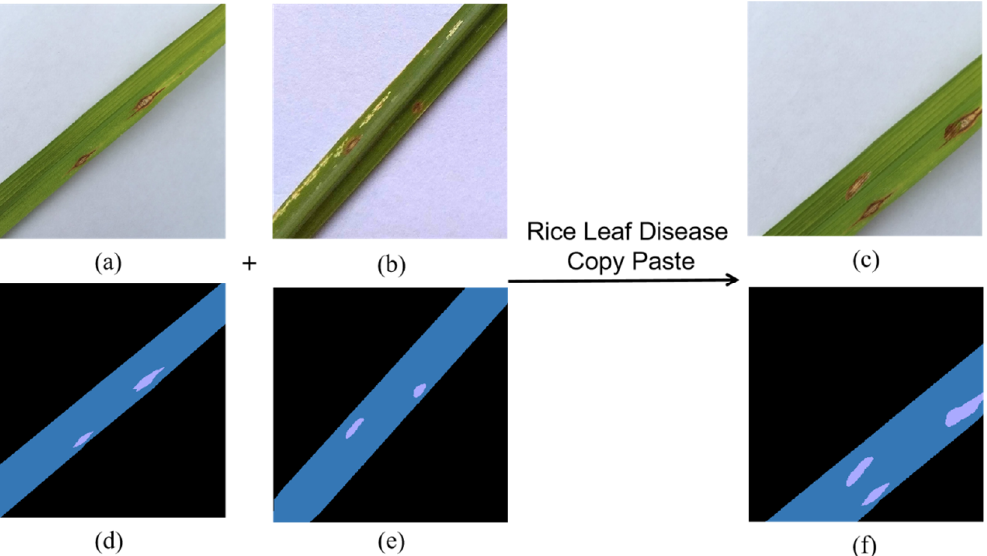
Figure 3. RLDCP data enhancement example: ( a ) RGB image of the pasted object, ( b ) RGB image of the copied object, ( c ) newly synthesised RGB image, ( d ) mask image of the pasted object, ( e ) mask image of the copied object, ( f ) newly synthesised mask image.